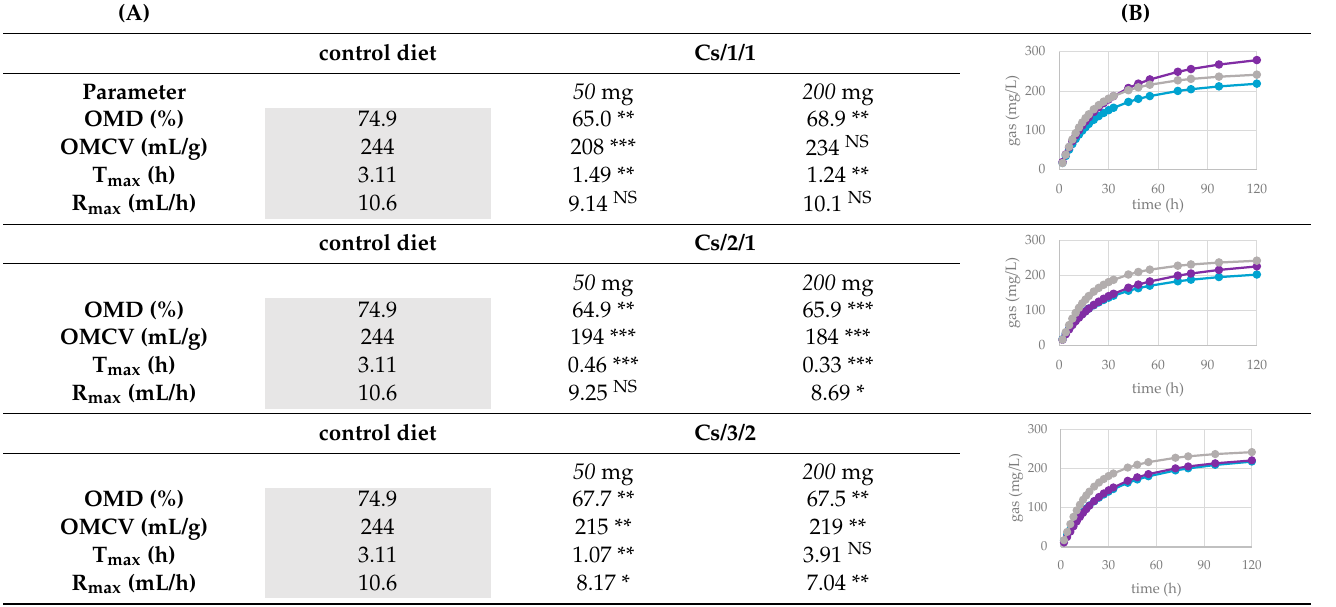
Table 5. ( A ) In vitro cumulative gas production, organic matter degradability, and fermentation kinetics parameters of different C. sativa extracts. OMD: organic matter degradability; OMCV: Molecules 2022 , 27 , x FOR PEER REVIEW 14 of 25 cumulative volume of gas related to incubated OM. R max : maximum fermentation rate; T max : time Table 5. (A) In vitro cumulative gas production, organic matter degradability, and fermentation at which R max occurs. * p < 0.05, ** p < 0.01 and *** p < 0.001. NS : not significant. ( B ) In vitro gas Table 5. (A) In vitro cumulative gas production, organic matter degradability, and fermentation kinetics parameters of different C. sativa extracts. OMD: organic matter degradability; OMCV: Table 5. (A) In vitro cumulative gas production, organic matter degradability, and fermentation kinetics parameters of different C. sativa extracts. OMD: organic matter degradability; OMCV: production over time of C. sativa Cs/1/1 extract and its fractions Cs/2/1 and Cs/3/2 at 50-mg ( • ) cumulative volume of gas related to incubated OM. R max : maximum fermentation rate; T max : time at kinetics parameters of different C. sativa extracts. OMD: organic matter degradability; OMCV: cumulative volume of gas related to incubated OM. R max : maximum fermentation rate; T max : time at which R max occurs. * p < 0.05, ** p < 0.01 and *** p < 0.001. NS : not significant. (B) In vitro gas which R max occurs. * p < 0.05, ** p < 0.01 and *** p < 0.001. NS : not significant. (B) In vitro gas cumulative volume of gas related to incubated OM. R max : maximum fermentation rate; T max : time at and 200-mg ( • ) dose levels and control diet ( • ). production over time of C. sativa Cs/1/1 extract and its fractions Cs/2/1 and Cs/3/2 at 50-mg ( ● ) and production over time of C. sativa Cs/1/1 extract and its fractions Cs/2/1 and Cs/3/2 at 50-mg ( ● ) and which R max occurs. * p < 0.05, ** p < 0.01 and *** p < 0.001. NS : not significant. (B) In vitro gas 200-mg ( ● ) dose levels and control diet ( ● ). 200-mg ( ● ) dose levels and control diet ( ● production over time of C. sativa Cs/1/1 extract and its fractions Cs/2/1 and Cs/3/2 at 50-mg ( ● ) and 200-mg ( ● ) dose levels and control diet ( ● ).